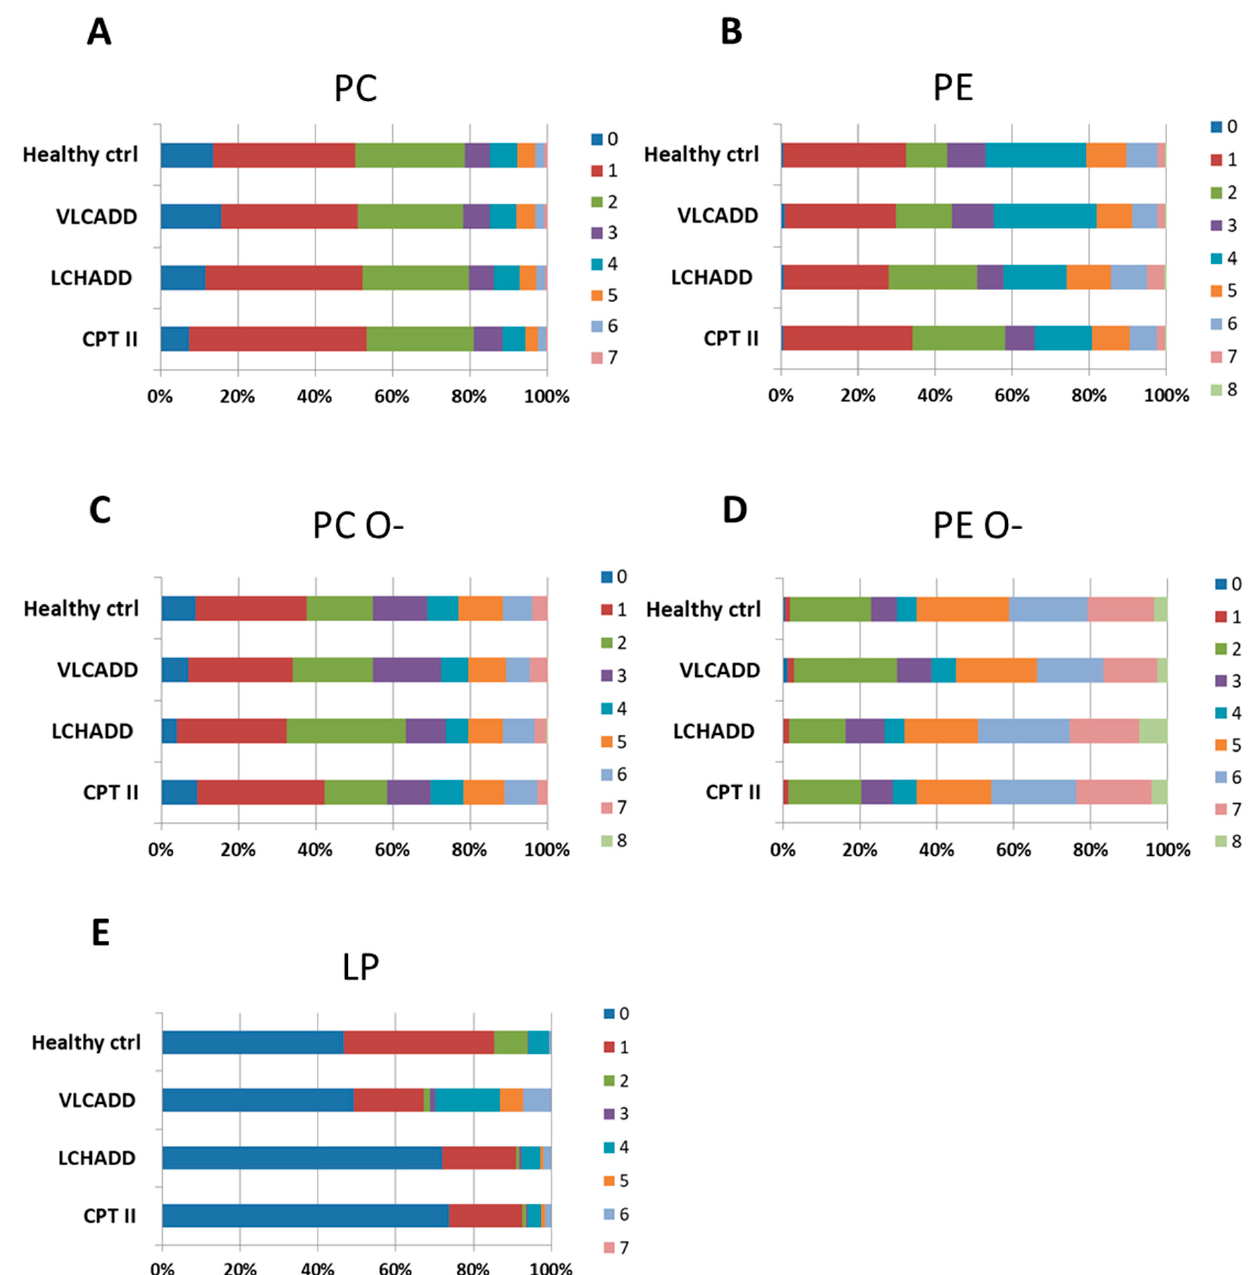
Figure 3. Representation of the desaturation degree in phosphatidylcholine ( A ), phosphatidylethanolamine ( B ), their corresponding plasmalogens PC O-: Phosphatidylcholine (-ether) ( C ) and PC O-: Phosphatidylethanolamine (-ether)-( D ) and lysophospholipids ( E ). Concentrations of the measured fatty acid chain length are represented as percentages. Mol % sample: indicates the moles of the lipid species extracted from one sample calculated as percentage of the total amount of lipid extract.